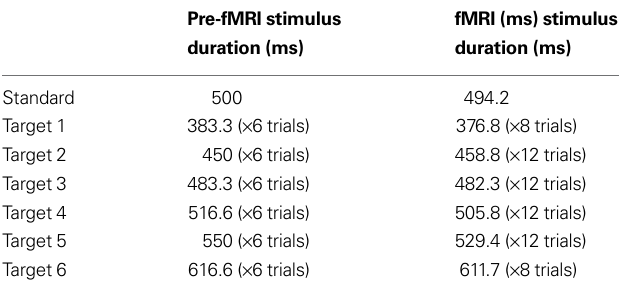
Table 1 | Stimulus characteristics. Stimulus duration for the pre-fMRI and the fMRI session for the standard stimulus and the target stimulus, which varied with the presentation of six different